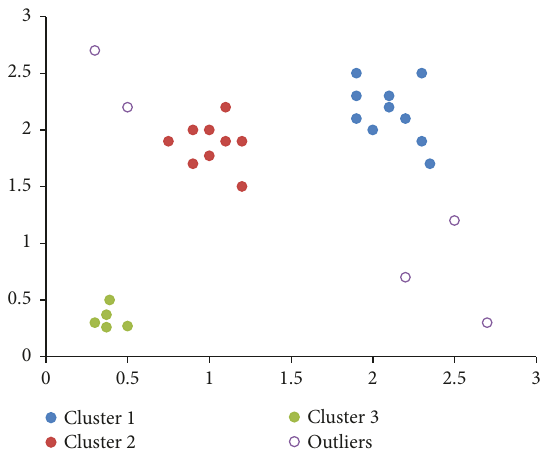
Figure 12: The distribution of Spiral.